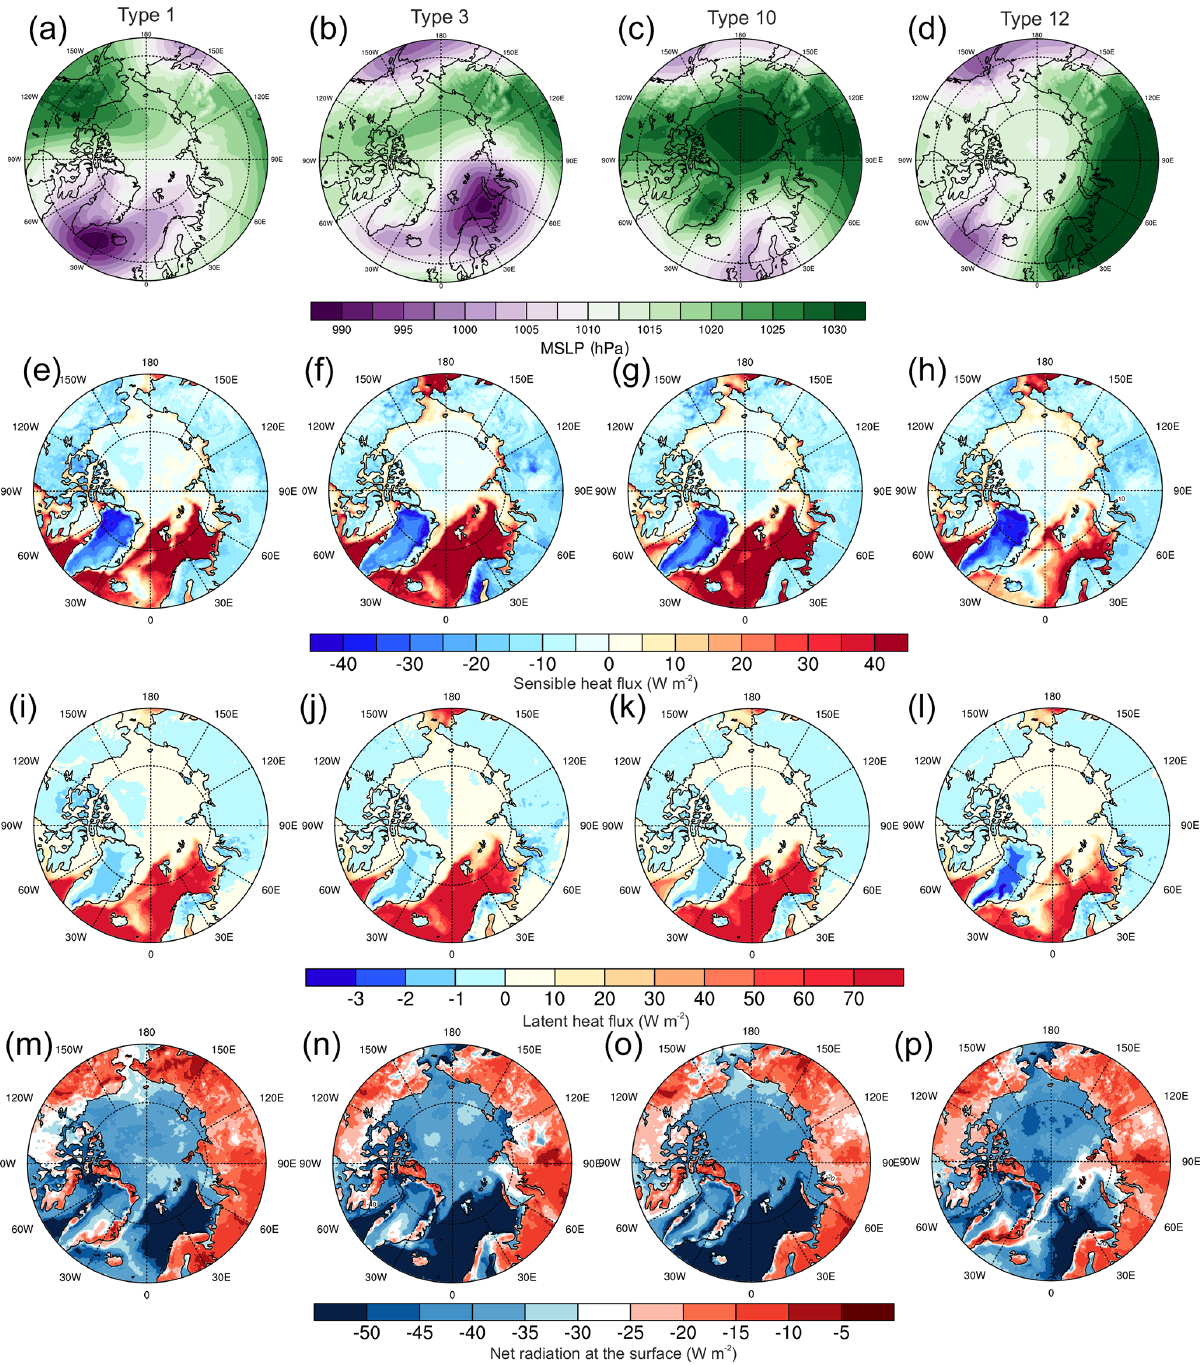
Figure 4. Mean sea level pressure (a–d) , sensible heat flux (e–h) , latent heat flux (i–l) and net radiation at the surface (m–p) in four SOM circulation types (indicated on the top of the column) during December–February 2009–2018 based on ERA5. For sensible and latent heat fluxes, positive direction is defined to be upwards and for the net radiation downwards. Note the nonlinear scale for the latent heat flux.